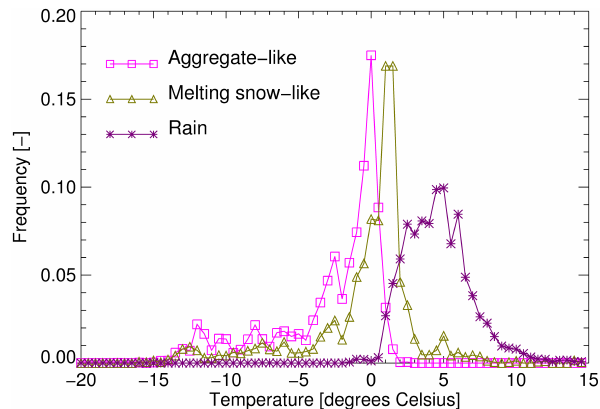
Figure 12. Distributions of the occurrence of AG, MS, and R as a function of air temperature. The distributions are obtained by aggre- gation of all the 2DVD measurements collected during the field ex- periments in Davos 2009–2011 and Remoray 2012–2013, and tem- perature data are given by closely located weather